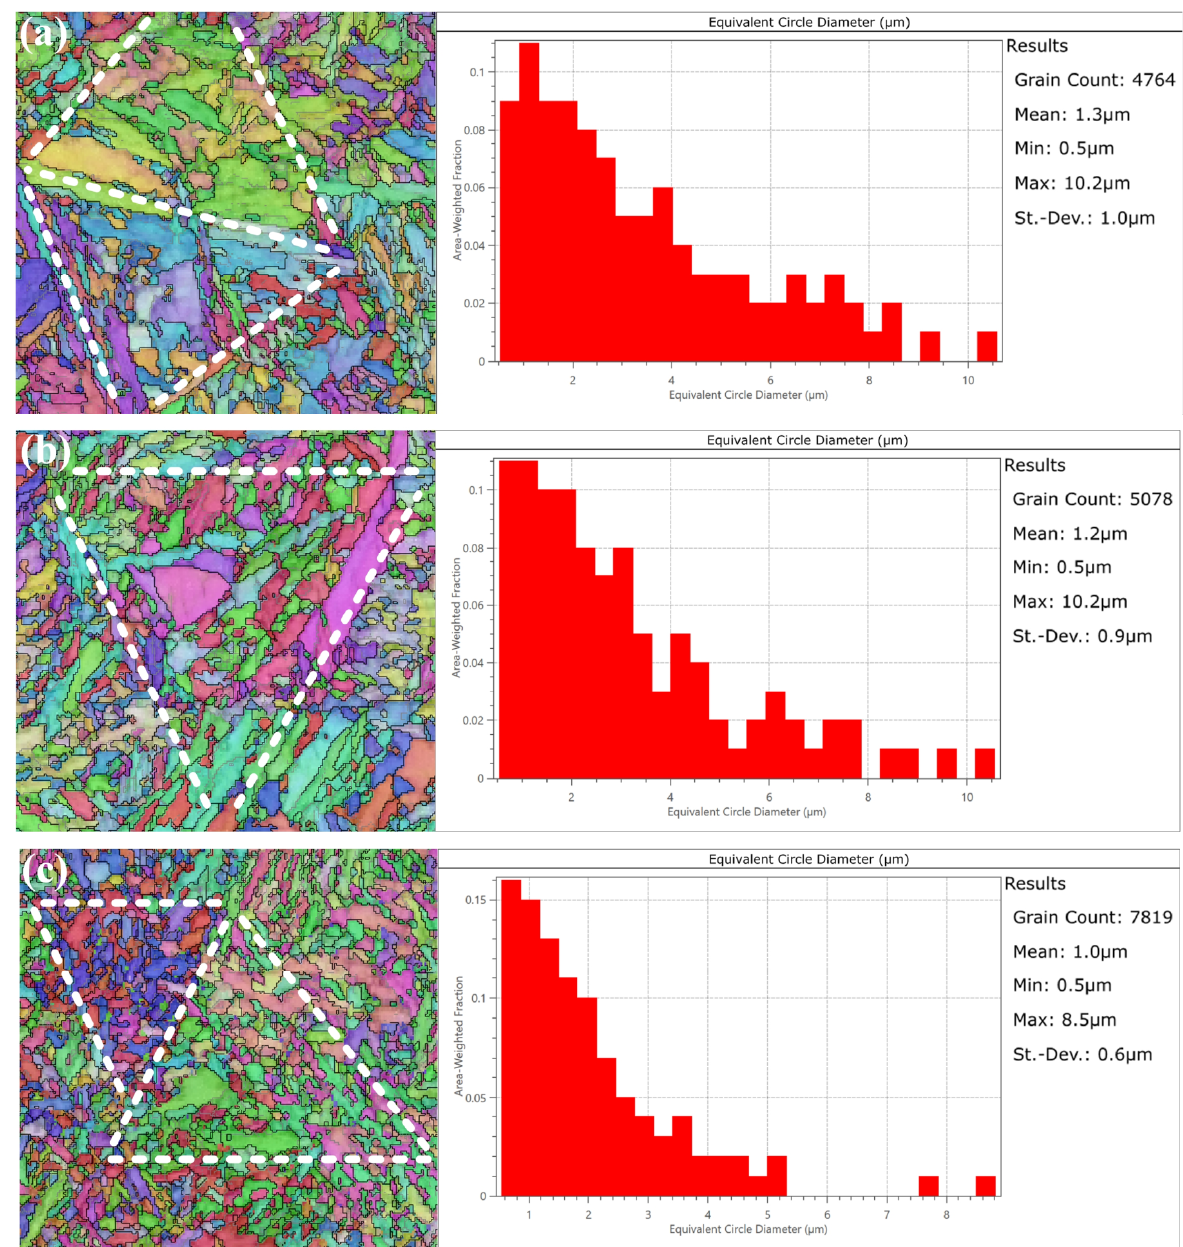
Figure 7. Grain size statistics and distribution patterns: ( a ) initial state; ( b ) surface layer of the tooth without grinding burns; ( c ) surface layer of the tooth with tempered grinding burns.